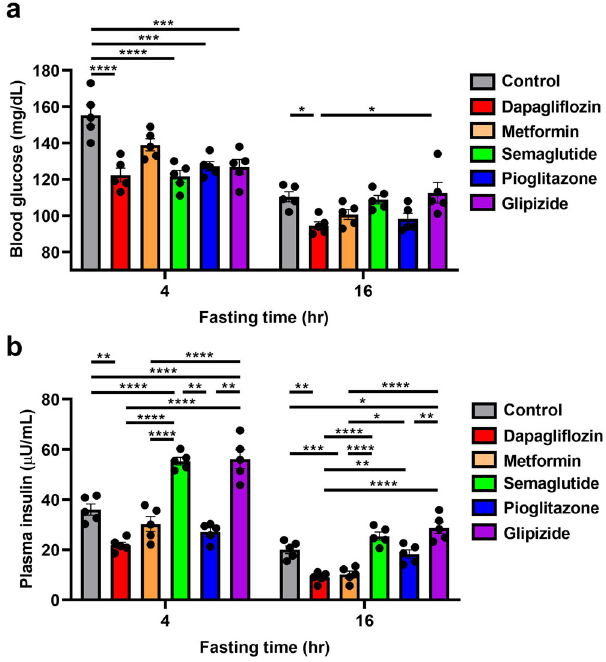
Fig. 1 The SGLT2 inhibitor dapagli fl ozin outperforms diabetes drugs in other classes at lowering both fasting and postprandial plasma insulin concentrations. Mice were fed a Western diet (60% calories from fat in chow, and 5% sucrose drinking water), for four weeks prior to initiation of drug treatment for two weeks. a Blood glucose. b Plasma insulin. In both panels, * P < 0.05, ** P < 0.01, *** P < 0.001, **** P < 0.0001 by ANOVA with Tukey ’ s multiple comparisons test. In both panels, n = 5 per